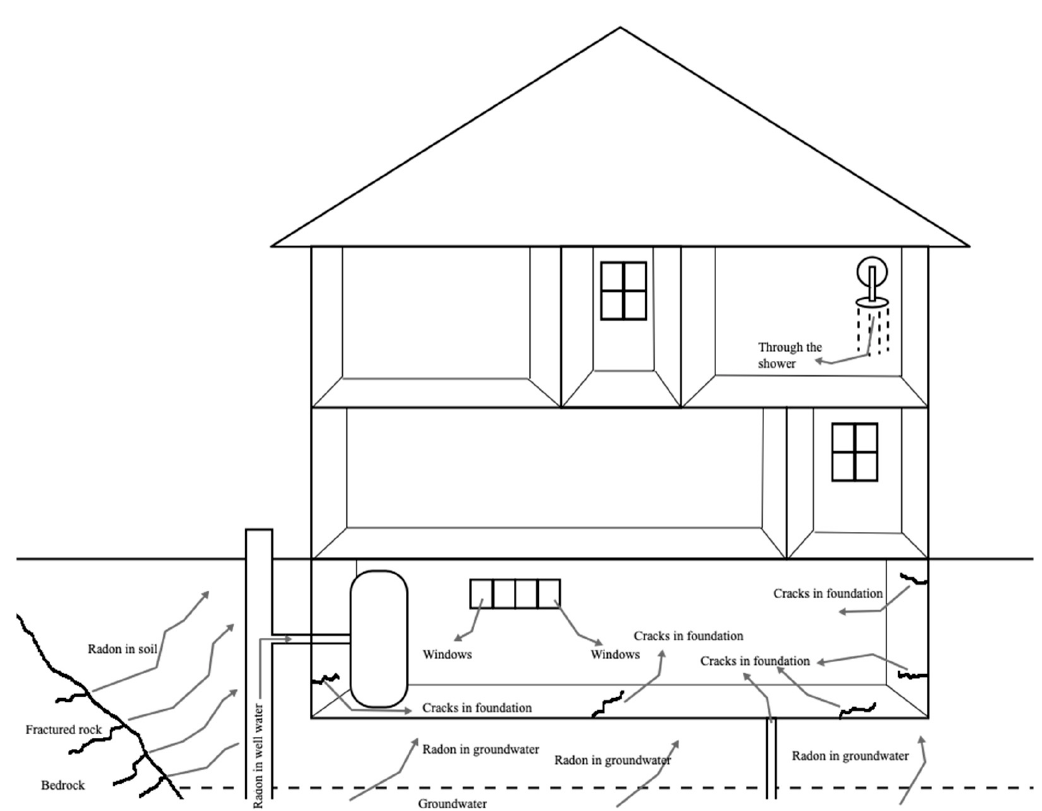
Figure 3. Radon can enter into buildings through cracks in the building structure after being released from rocks to soils and water. Water can transport radon into the buildings, as being highly soluble in cold water, this solubility is highly reduced in hotter water, being immediately released, for example, during showering (adapted from [43–46]).